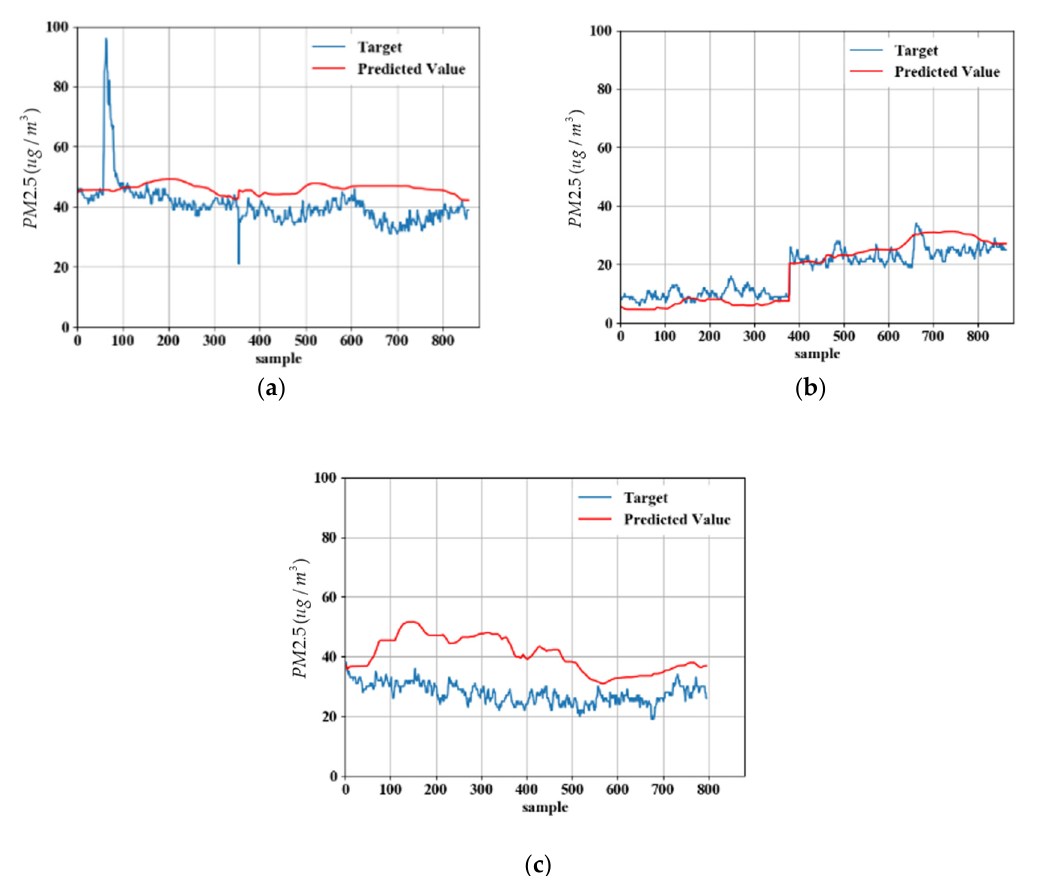
Figure 21. Prediction results of the RBF neural network model: model prediction results for ( a ) 15 February, ( b ) 28 February, and ( c ) 1 March 2019.